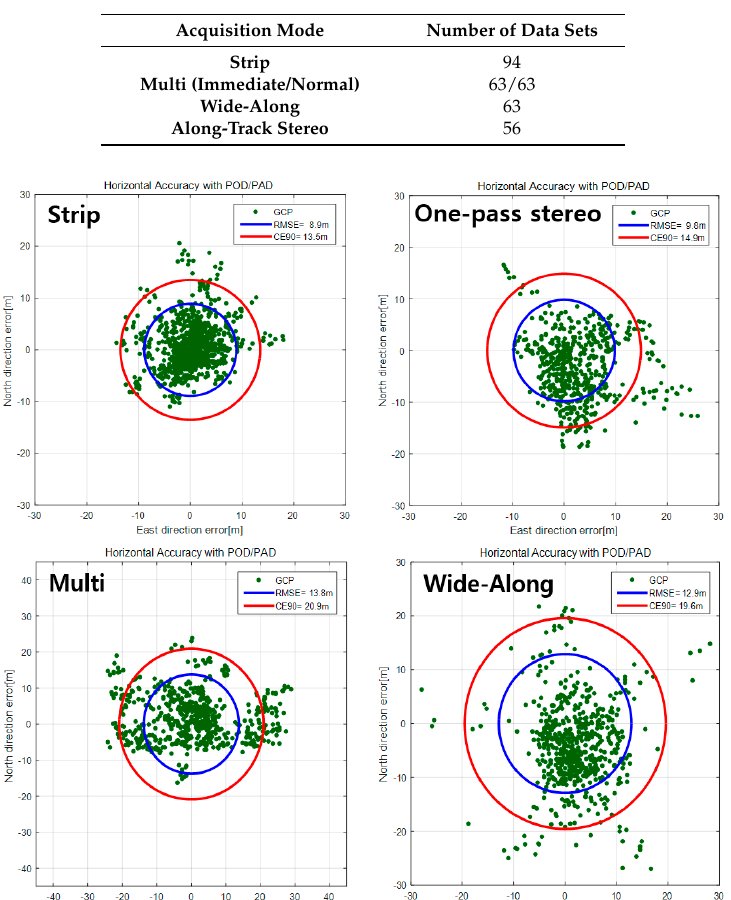
Figure 12. Horizontal accuracy for various acquisition modes without any GCPs. Sensors 2016 , 16 , 1776